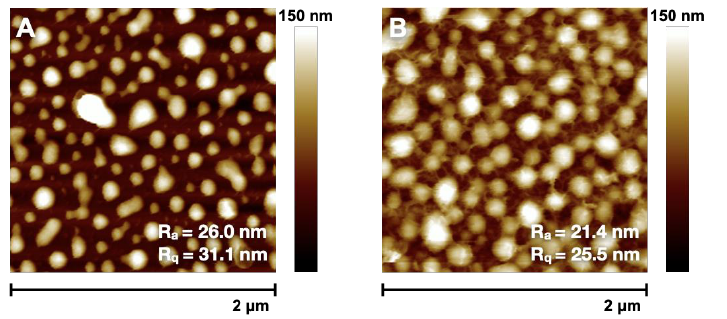
Figure 4. AFM pictures of the topography of donor – acceptor poly( St-D - alt - Ma-A ) brushes obtained via RAFT polymerization: ( A ) before and ( B ) after oxidative polymerization with FeCl 3 .